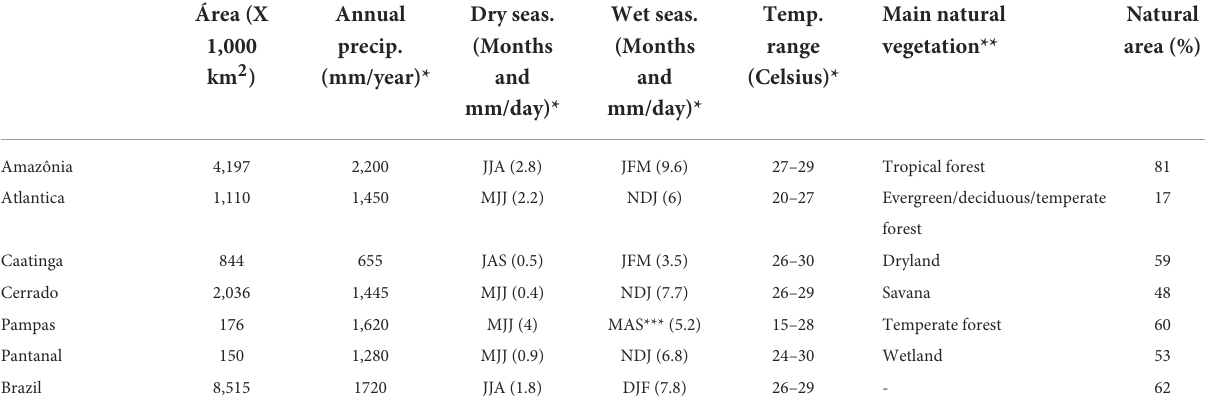
TABLE 2 Area, total annual precipitation, months and mean of daily precipitation for the dry and wet seasons, temperature range (minimum and maximum), main vegetation, and percent of natural area for each biome and Brazil.